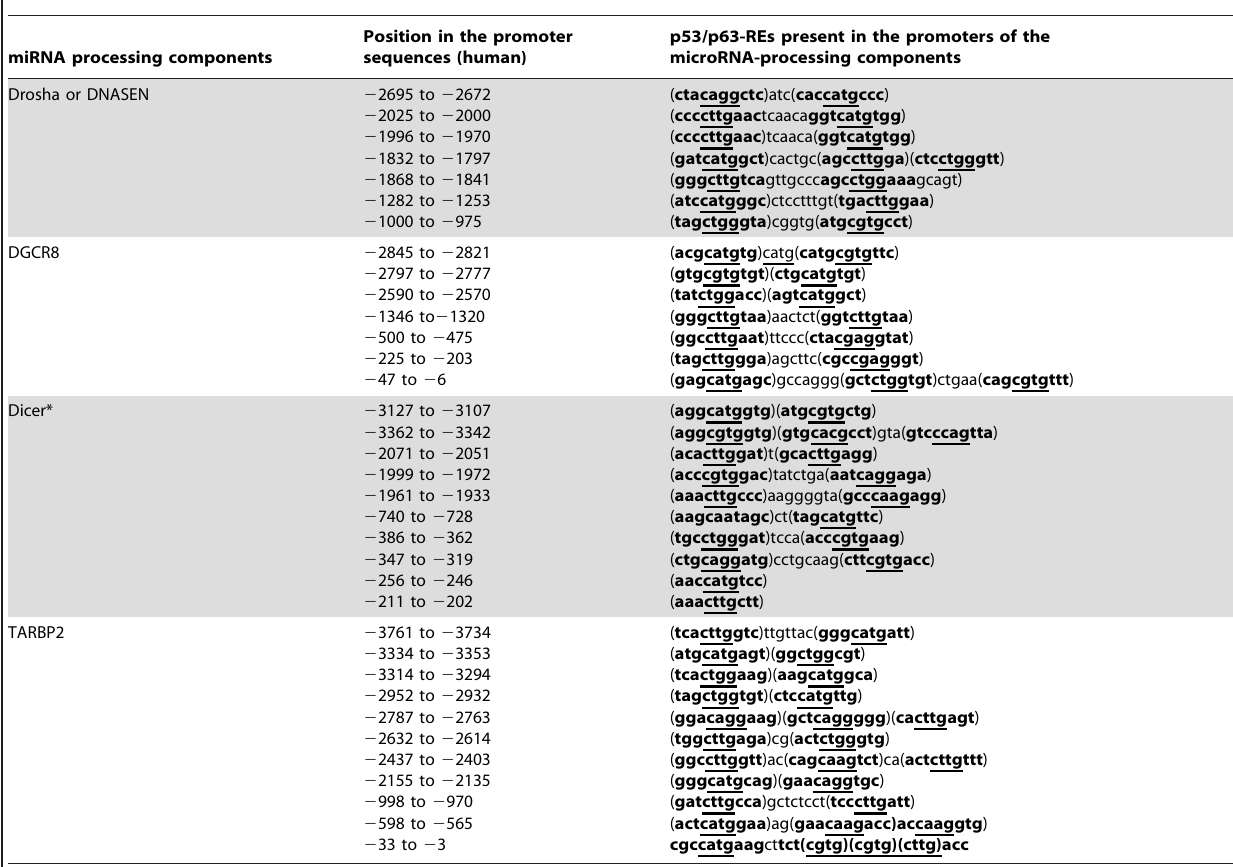
Table 1. The promoters of the key components of the miRNA processing machinery contain p53/p63-REs.